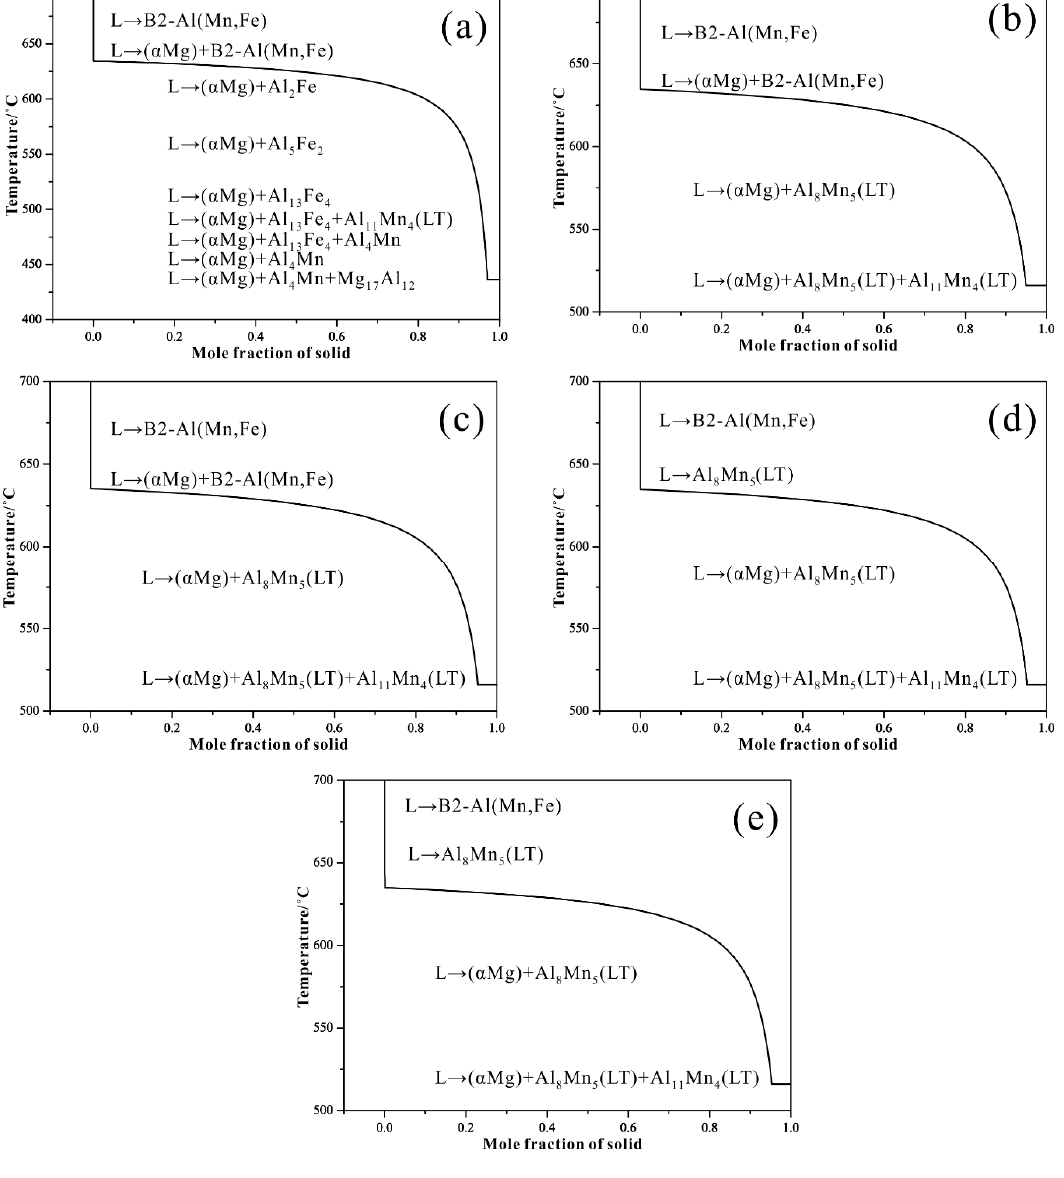
Figure 10. Calculated Scheil solidification paths of the alloys: ( a ) Mg-2.97Al-0.01Mn-0.013Fe, ( b ) Mg-2.98Al-0.12Mn-0.01Fe, ( c ) Mg-2.86Al-0.21Mn-0.01Fe, ( d ) Mg-2.97Al-0.36Mn-0.008Fe, ( e ) Mg-2.96Al-0.45Mn-0.015Fe.